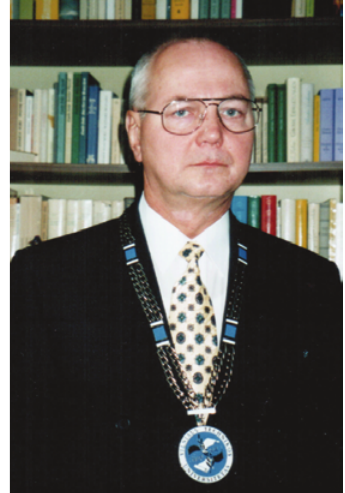
Fig. 2. Professor Friedel Peldschus was granted an Honorary Doctorate at Vilnius Technical University in